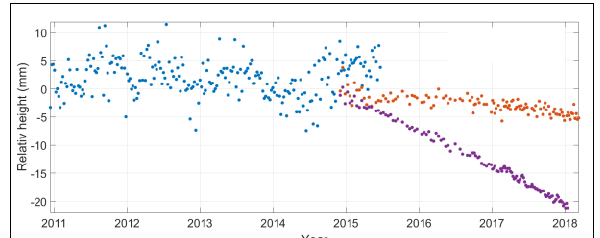
Figure 4: Time series of processed GNSS and PS cluster in WH. In blue are GNSS results at gauging station, in red are results from nearest PS cluster, in purple are PS results of Figure 6: Time series of processed GNSS data and PS cluster at strongest motion area the gauging station of Cuxhaven Steubenhöft